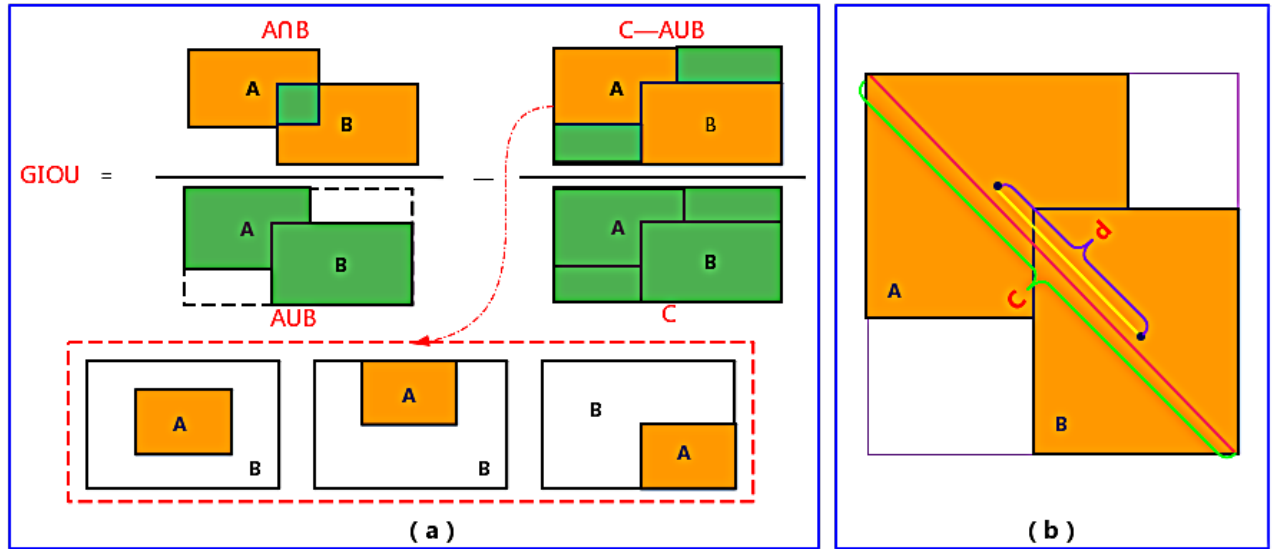
Figure 3. Structure of loss function. ( a ) GIOU (Generalized Intersection over Union): A and B indicate that the boxes of true and predicted, the red dotted box indicates the special position of A and B, the green area means the required intersection area. ( b ) C indicates the diagonal distance from the minimum circumscribed rectangle bounding A and B. d indicates that the Euclidean distance between the center points of the boundary box A and B.